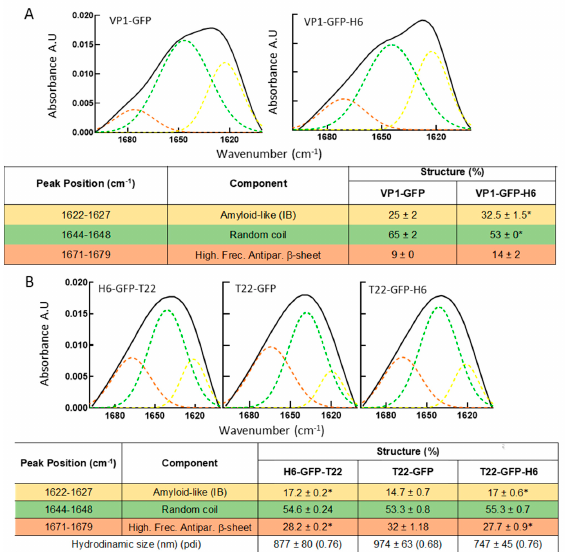
Figure 2. ATR-FTIR spectra of IBs. Amide I band (black) and components resulting from deconvo- lution (in colors), for two sets of proteins, namely ( A ) and ( B ). At the bottom, deconvolution results of the spectra analyses as percentages of the components within each IBs. Colored peak components match with the table rows. * Statistically different with respect to the non ‐ tagged equivalent proteins ( p < 0.1). The VP1 ‐ GFP conformational features were in accordance with previous studies applying the same procedure [58].